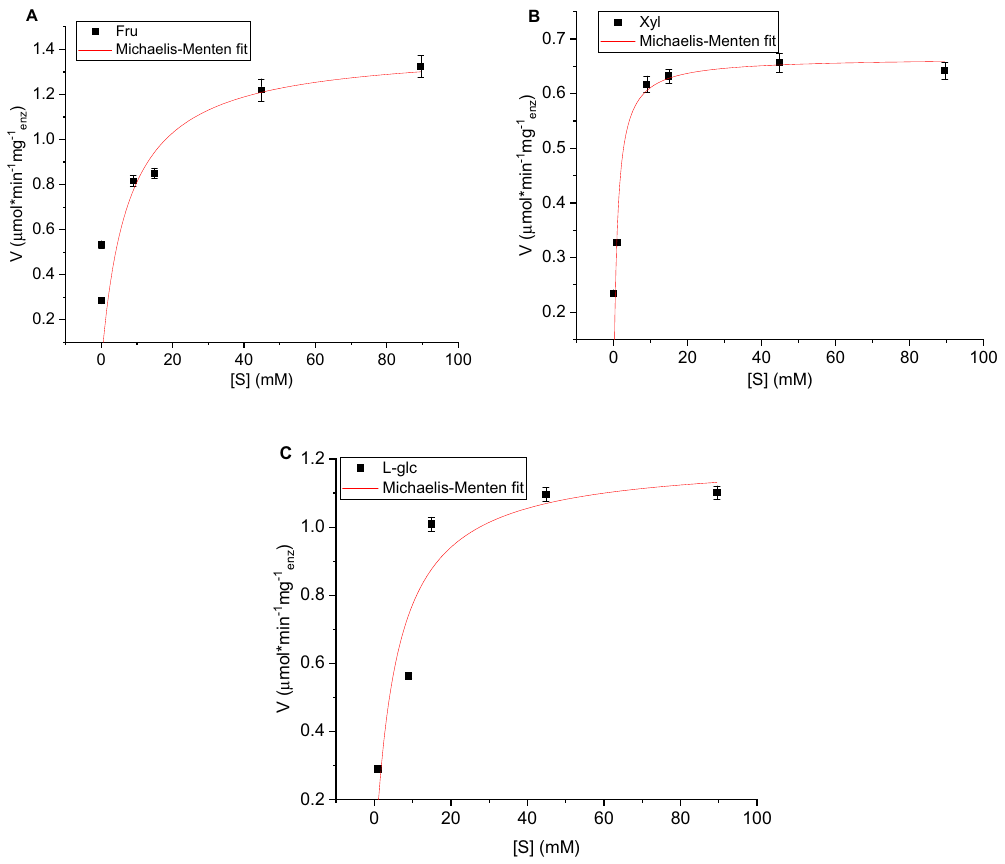
Figure 3. Michaelis–Menten analyses of GOx@Au activity towards ( A ) fructose, ( B ) xylose, and ( C ) l-glucose; error bars are shown.